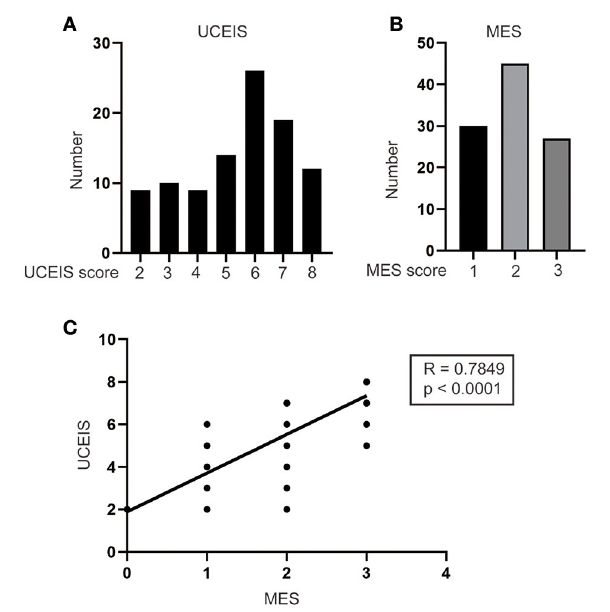
FIGURE 2 | Analysis of the distribution and correlation of ulcerative colitis endoscopic index of severity (UCEIS) and Mayo endoscopic score (MES). The number of patients with different (A) UCEIS and (B) MES were analyzed. (C) Significant correlations existed between the UCEIS and MES ( R = 0.7849, p < 0.0001).